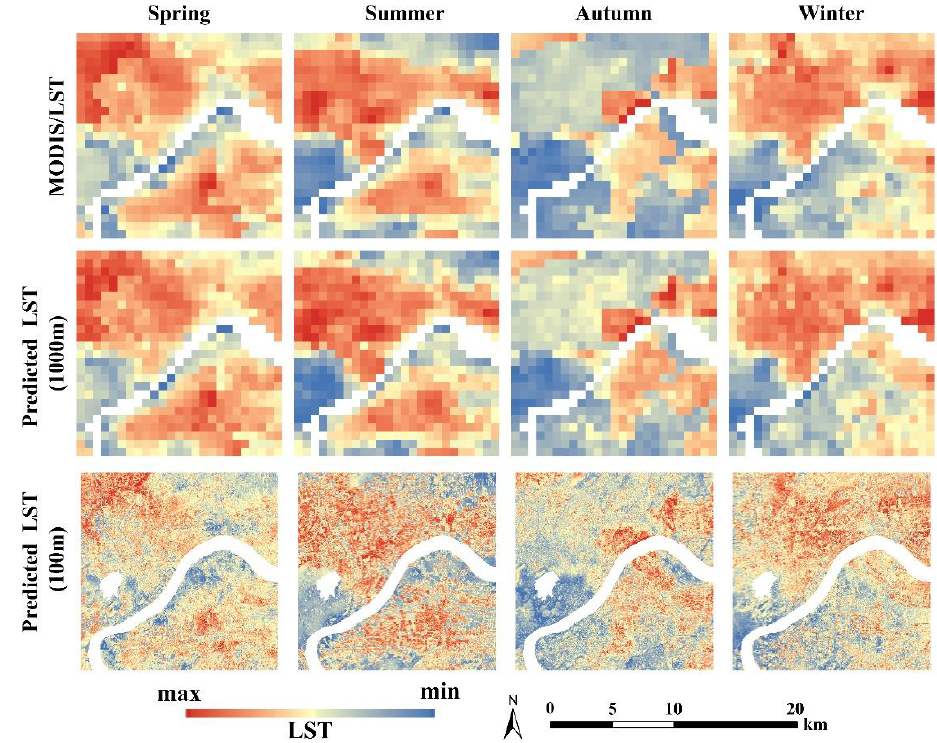
Figure 14. Predicted and downscaling results during daytime at different scales in various seasons from MODIS/LST products.